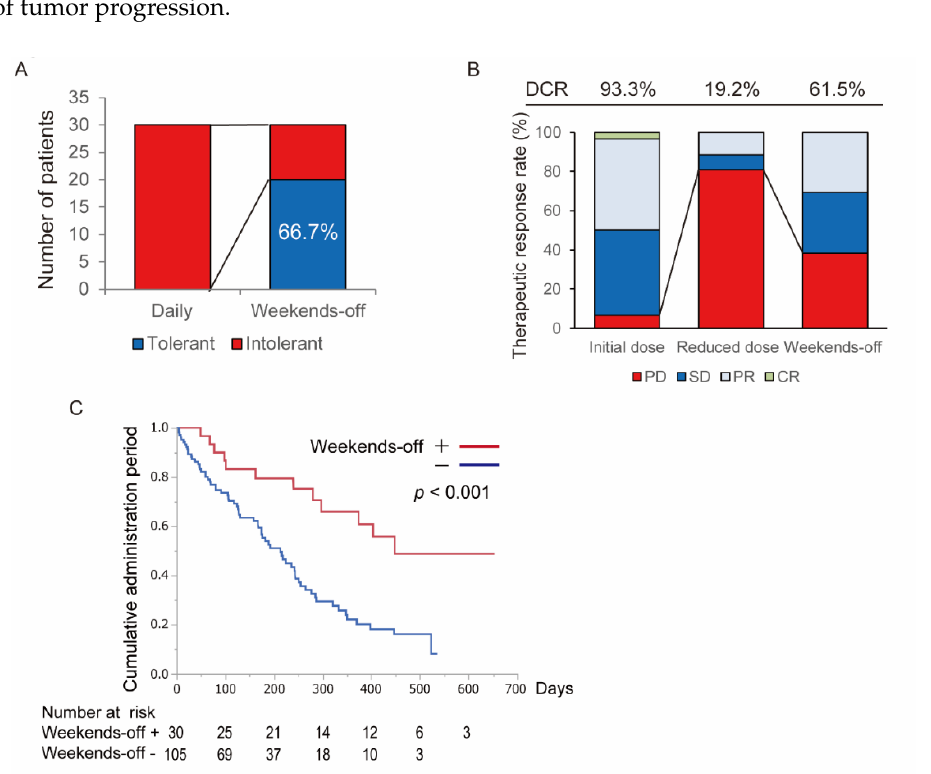
Figure 4. Assessment of the weekends-off administration of lenvatinib. ( A ) Tolerability toward adverse events (AEs) (66.7% of patients were tolerant to lenvatinib-induced AEs). ( B ) Therapeutic response according to the type of lenvatinib protocol. The disease control rate (DCR) of patients treated with lenvatinib at the initial daily dose was 93.3%. After dose reduction due to the appearance of adverse events, the DCR was reduced to 19.2%. After switching to the weekends-off protocol, the DCR increased to 61.5%. ( C ) Duration of lenvatinib administration in 30 patients treated using the weekends-off protocol (red line) and 105 patients treated using the continuous daily administration protocol (blue line). The median administration period of patients who were treated with the weekends-off protocol was significantly longer than that of patients treated with the continuous protocol ( p < 0.001). ( D ) The survival curve of patients treated with lenvatinib. The red line shows the survival curve of patients who followed the weekends-off protocol and the blue line shows the survival curve of patients who followed the standard (continuous daily administration) protocol. The